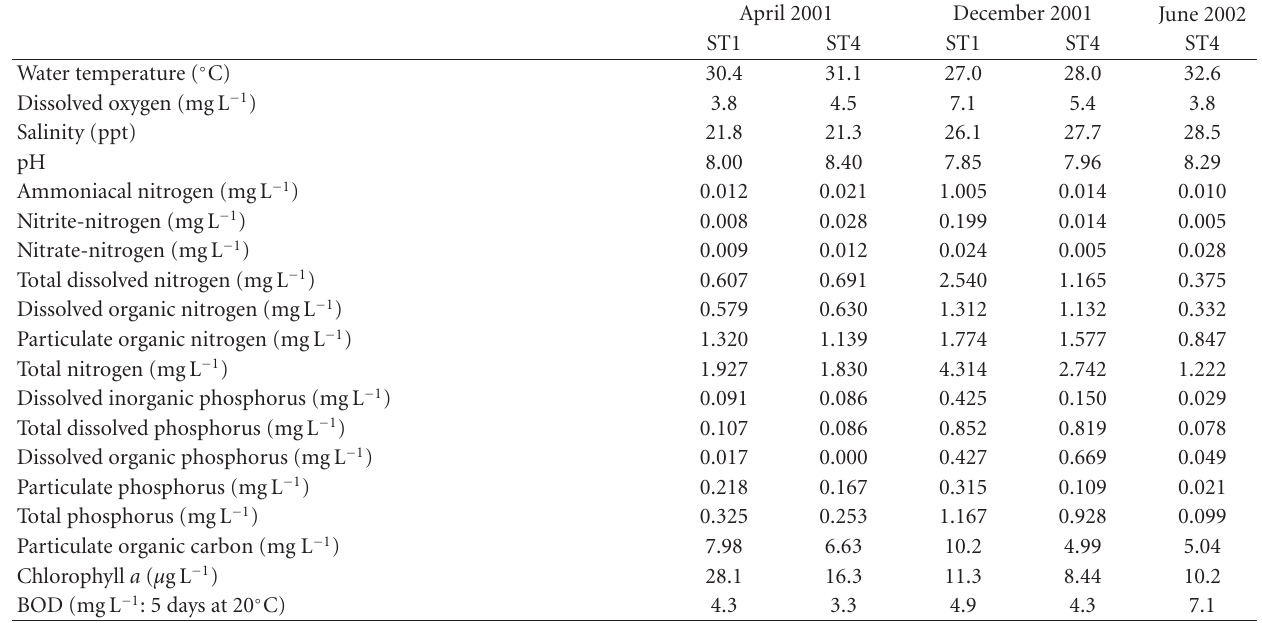
Table 1: Results of water analyses conducted in April 2001, December 2001, and June 2002.